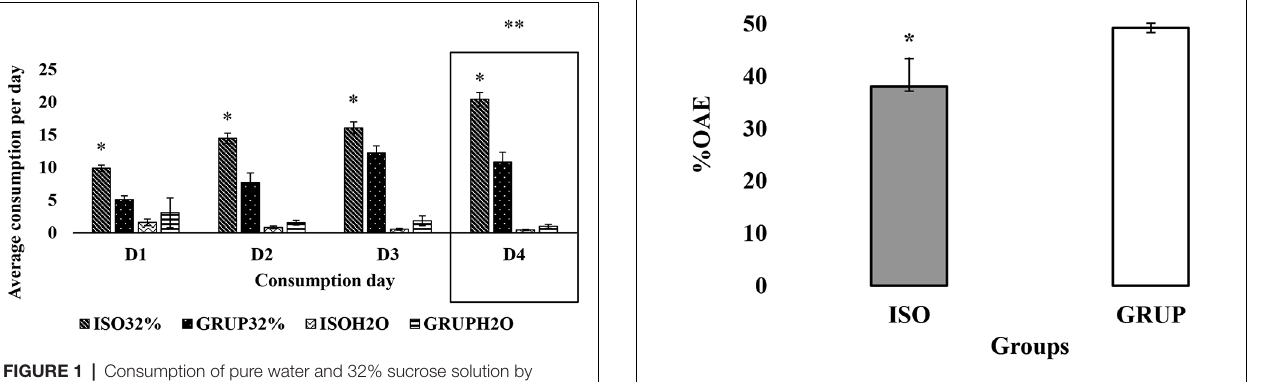
FIGURE 3 | Exploration of the open arms of the elevated-plus-maze (EPM). Exploration of the open arms of the EPM. OAE y %OAE (PROM ± EE) in EPM, in the groups ISO (isolated) y GRUP (grouped). *Less %OAE in ISO than GRUP; Mann–Whitney Test t, p < 0.05. Exploration in the Elevated-Plus-Maze